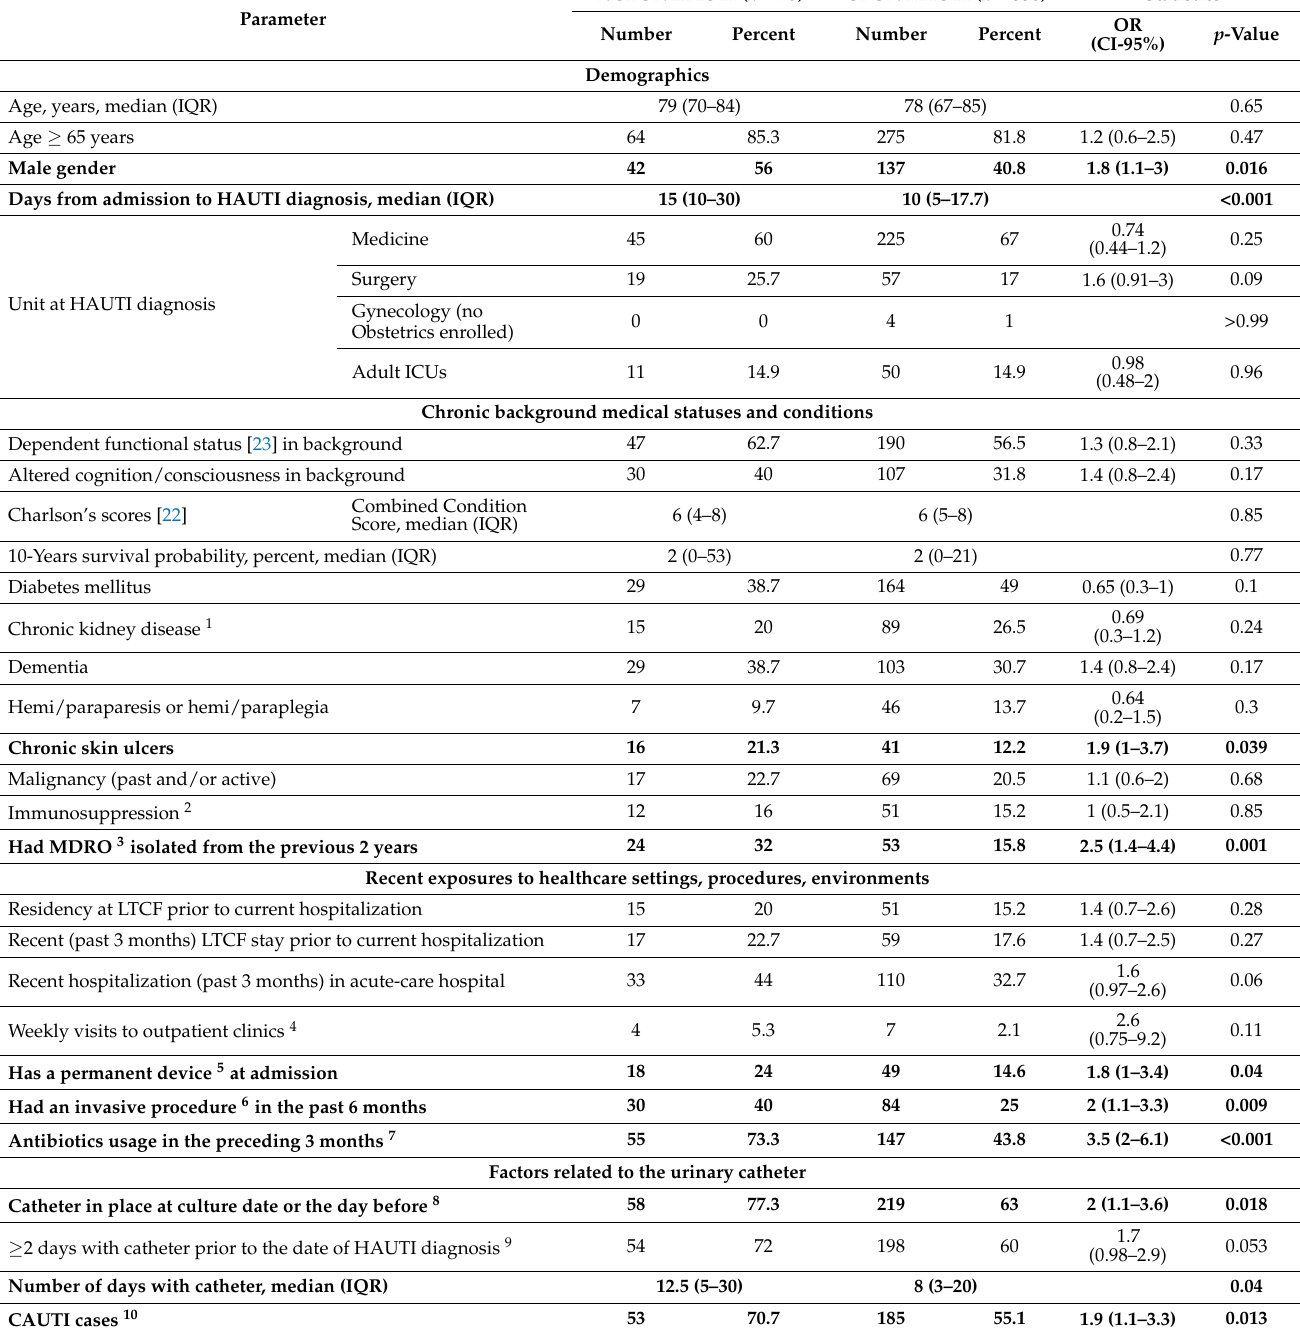
Table 2. Predictors and outcomes of hospital-acquired urinary tract infections (HAUTI) resulting from non-glucose fermenting Gram negatives (NGFGN), Shamir Medical Center,